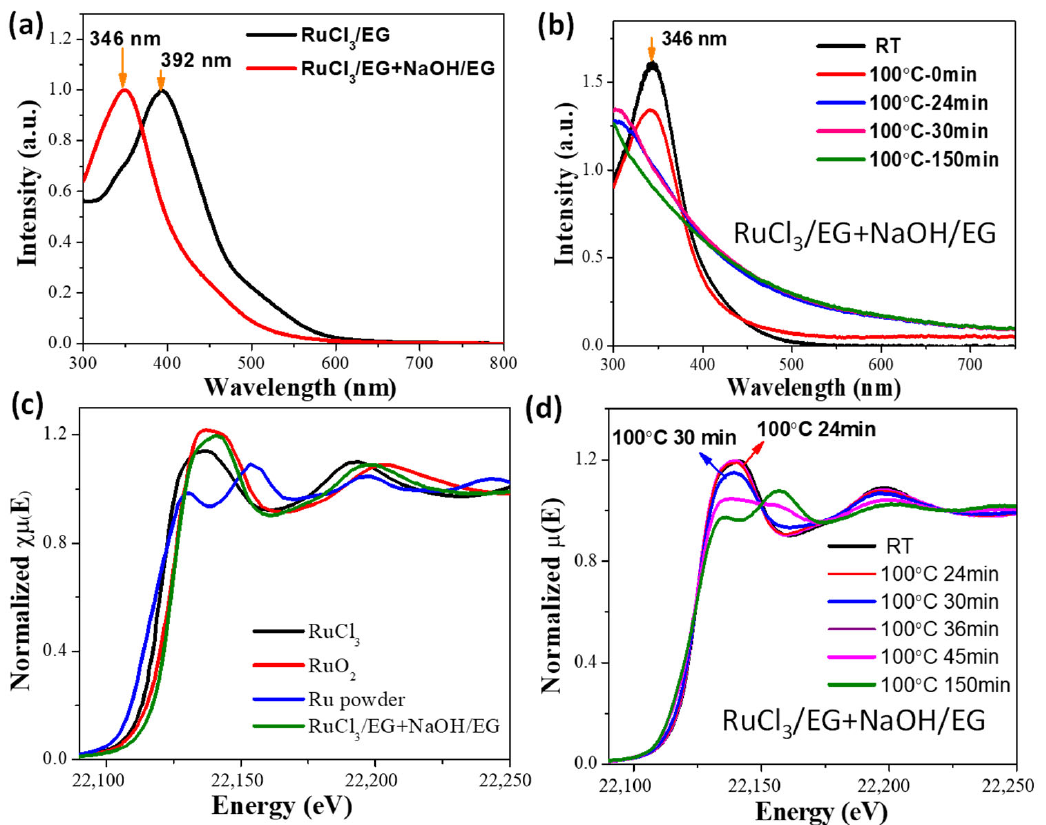
Figure 1. In situ characterization of colloidal nanoclusters. ( a ) UV ‐ vis absorption spectra of RuCl 3 glycol solution and RuCl 3 ‐ NaOH/EG solution; ( b ) the in situ UV ‐ vis absorption spectra of reaction mixture for preparing unprotected Ru nanoclusters under different conditions; ( c ) Ru K ‐ edge XANES spectra of Ru powder, RuCl 3 glycol solution and RuO 2 powder; ( d ) time evolution of Ru K ‐ edge XANES spectra of reaction mixture for preparing unprotected Ru nanocluster under different conditions. Reproduced with permission, Copyright 2020 Editorial Office of Acta Physico ‐ Chimica Sinica [102] .